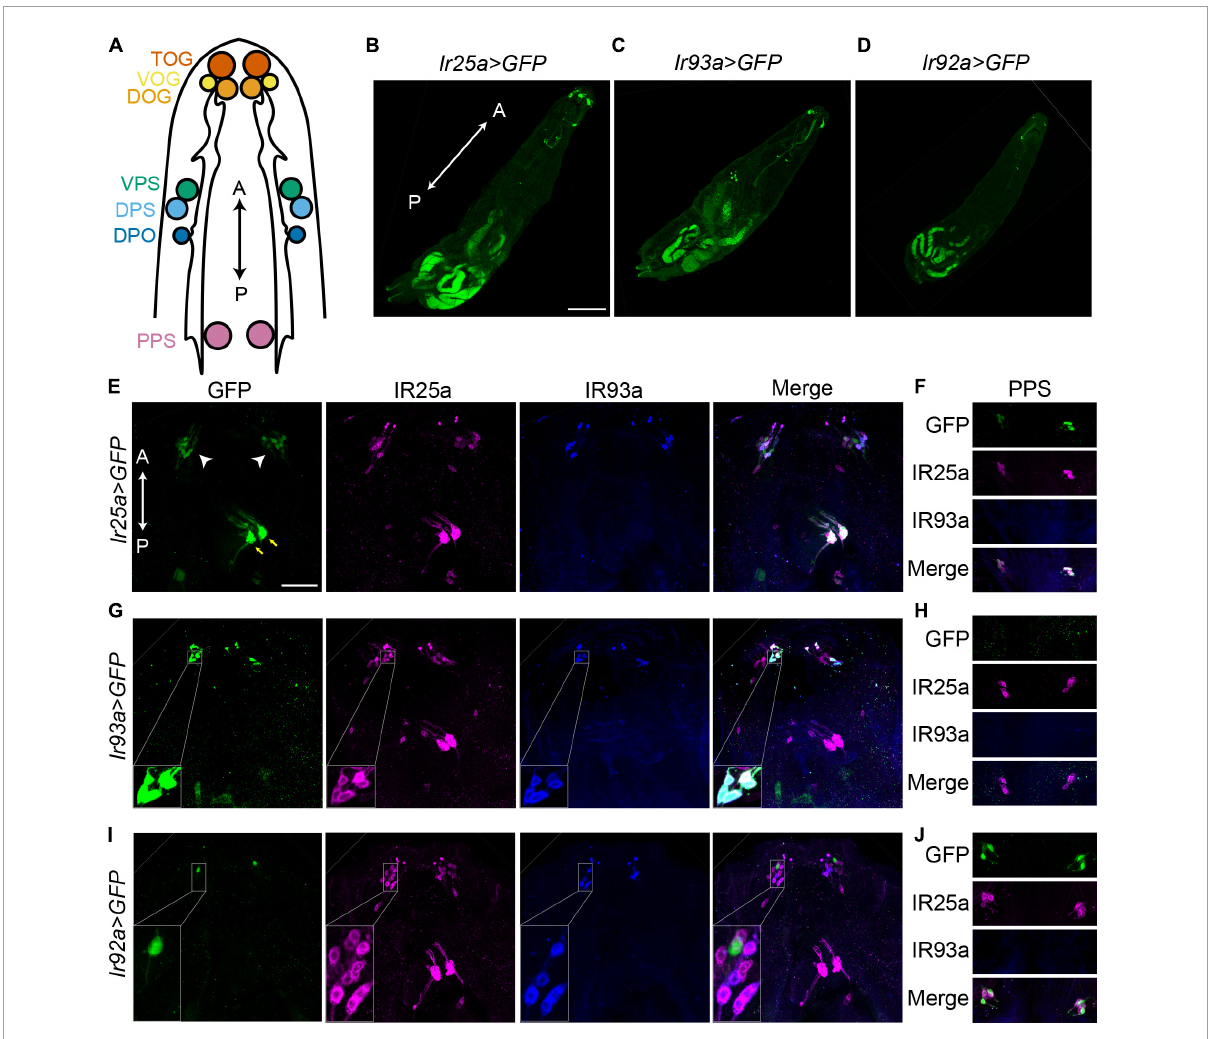
FIGURE2 IR93a and IR92a are not expressed in the same neurons. (A) The top view of a larval anterior part to show chemosensory organs, including the terminal organ ganglion (TOG), dorsal organ ganglion (DOG), ventral organ ganglion (VOG), dorsal pharyngeal sensilla (DPS), ventral pharyngeal sensilla (VPS), dorsal pharyngeal organ (DPO), and posterior pharyngeal sensilla (PPS). The orientation is shown by double headed arrows. A, anterior; P, posterior. (B–D) The expression of Ir25a-Gal4 (B) , Ir93a-Gal4 (C) , and Ir92a-Gal4 (D) in first instar larvae. Scale bars, 200 µ m. (E–J) Immunostaining of GFP [green; Ir25a > GFP (E,F) , Ir93a > GFP (G,H), and Ir92a > GFP (I,J) ], IR25a (magenta), and IR93a (blue) in the anterior part of third instar larvae. (E,G,I) include TOG, DOG, VOG, DPS, VPS, and DPO. White arrowheads: TOG, DOG, and VOG; yellow arrows: DPS, VPS, and DPO. (F,H,J) show PPS. Scale bars, 50 µ m. (G) Inset: Co-localization of Ir93a-Gal4 , an IR93a antibody, and an IR25a antibody in DOGs. (I) Inset: Ir92a-Gal4 is not co-expressed with an IR93a antibody or an IR25a antibody in DOGs. Ir25a > GFP : Ir25a-Gal4; UAS-GFP ; Ir93a > GFP : Ir93a-Gal4/UAS-GFP ; and Ir92a > GFP : Ir92a-Gal4/UAS-GFP